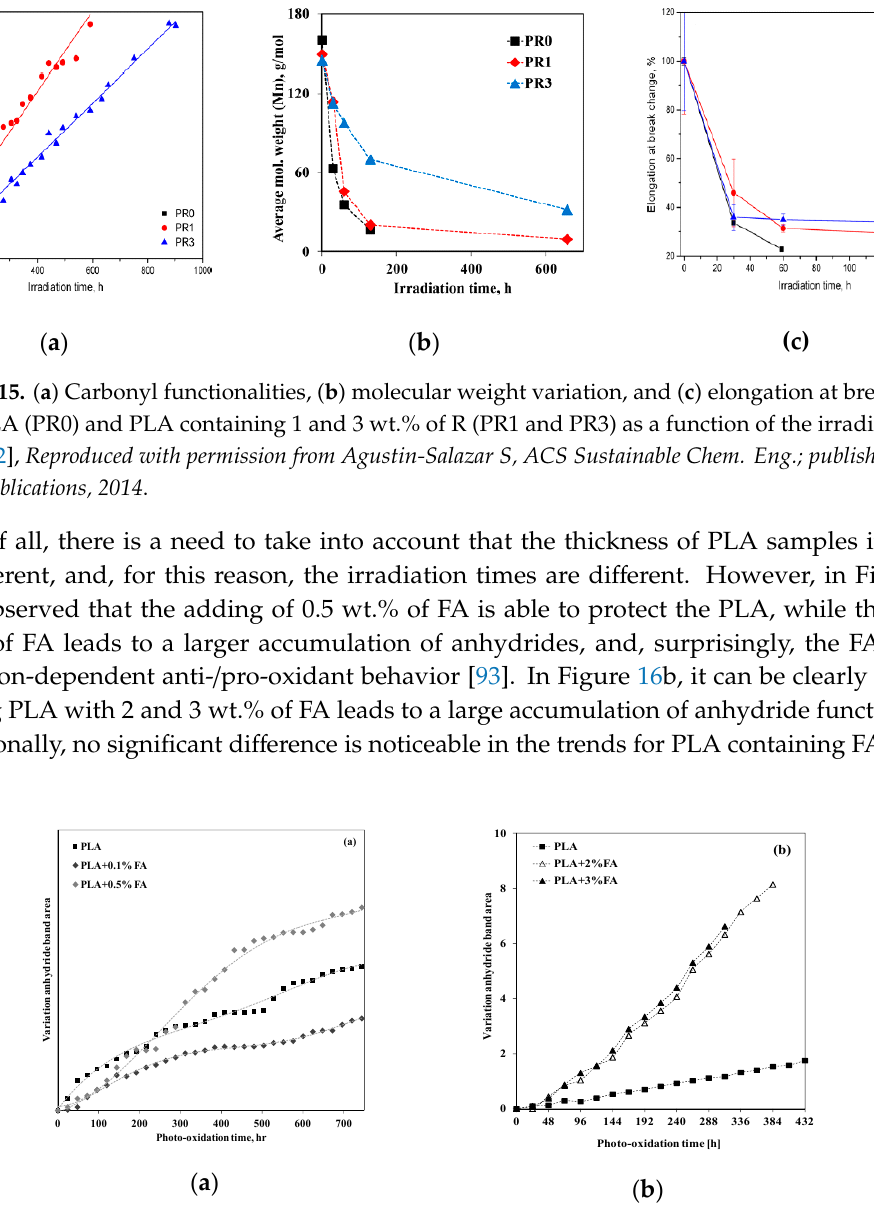
( b ) Figure 14. Dimensionless elongation at break, EB (t) /EB (t0) , of the starch-based biodegradable film (Mater-Bi ® ), additivated with ( a ) vitamin E (V-E) and quercetin (Q) and ( b ) synthetic antioxidant (AO) and light stabilizer (LS) [79], Reproduced with permission from Dintcheva NTz, J. Polym. Eng.; published by De Gruyter, 2014. In another study, to protect efficiently the biopolyester, i.e., polylactic acid (PLA), using nAO, the PLA has been additivated with resveratrol (R) at 0, 1, and 3 wt.% and prepared thin films have been subjected to UV-light exposure [82]. In Figure 15a–c, the trends of carbonyl accumulations, molecular weight variations, and elongation at break (EB) of PLA/R in comparison to neat PLA as a function of the irradiation time are shown. According to the literature, the hydrolytic degradation pathway of PLA, upon environmental humidity, leads to the formation of carboxylic acids end groups, while the main degradation pathway of PLA, upon UV exposure, proceeds with hydrogen abstraction on the polymer backbone and subsequent formation of radicals, which upon reacting with oxygen form peroxy radicals and hydroperoxides. The decomposition of the peroxy radicals and hydroperoxides, through β -scission reactions, leads to the formation of anhydrides. Therefore, the actions of both mentioned mechanisms lead to the significant decrease of PLA molecular weight due to the fragmentation of the macromolecules. Overall, as known, the UV exposure of polymers and biopolymers causes the formation of new chemical groups, e.g., carbonyl and hydroxyl functionalities, and, contemporarily, macromolecular chain scission, which leads to the loss of the macroscopical performance, such as reduction of elongation at break. In Figure 15a,b, the trends of carbonyl accumulation and molecular weight variation of neat PLA and PLA/R are reported, and it can be observed that the presence of R leads to less pronounced accumulation of carbonyl functionalities and reduction of the molecules’ weight, highlighting the protection ability of R towards UV irradiation. Additionally, the EB for neat PLA film goes to very low values at short exposure time than the samples of PLA containing 1 and 3 wt.% of R, suggesting again a good